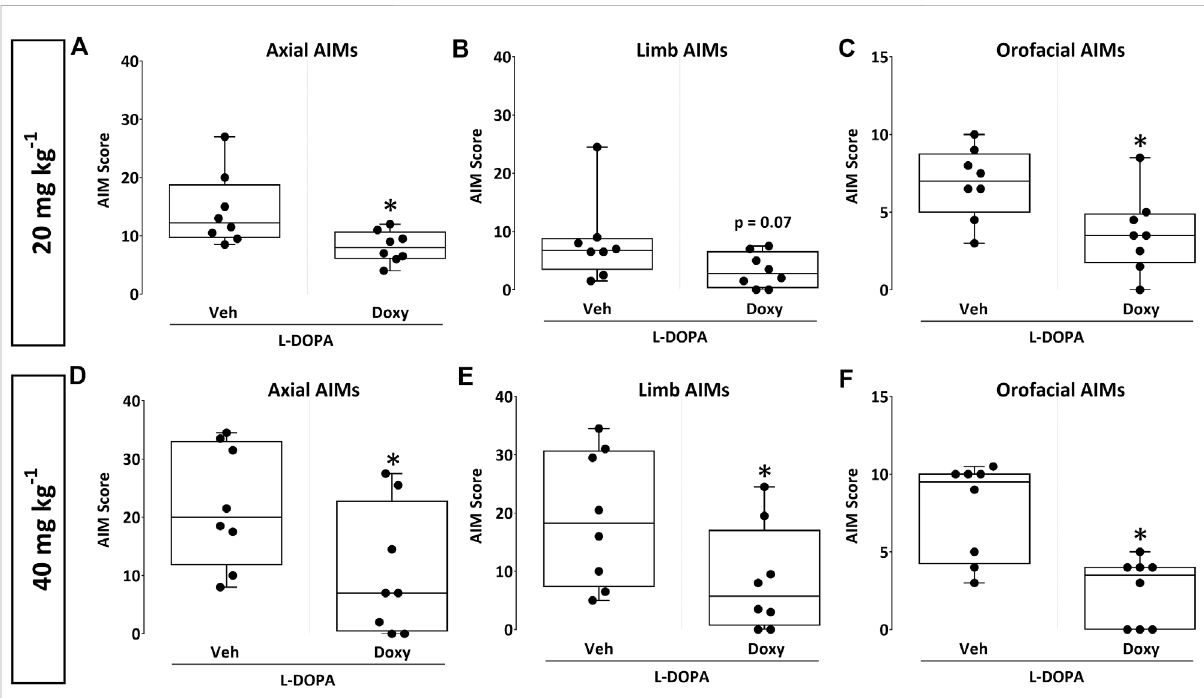
Box plot charts showing the impact of treatment with 20 and 40 mg kg − 1 of Doxy on speci fi c subtypes of AIMs. (A – C) Impact of Doxy 20 mg kg − 1 on axial (A) limb (B) and orofacial (C) AIMs compared to the Veh-treated group in hemiparkinsonian mice with moderate striatal lesions. (D – F) Impact of Doxy 40 mg kg − 1 on axial (D) limb (E) and orofacial (F) AIMs compared to the Veh-treated group in hemiparkinsonian mice with intermediate striatal lesions. Box plots represent the summary of the dataset for each parameter (minimum, lower quartile, median, upper quartile, and maximum). * p < 0.05 vs. Veh, Mann-Whitney test, n = 8/group. Note that the p -value in b is close to signi fi cance ( p =